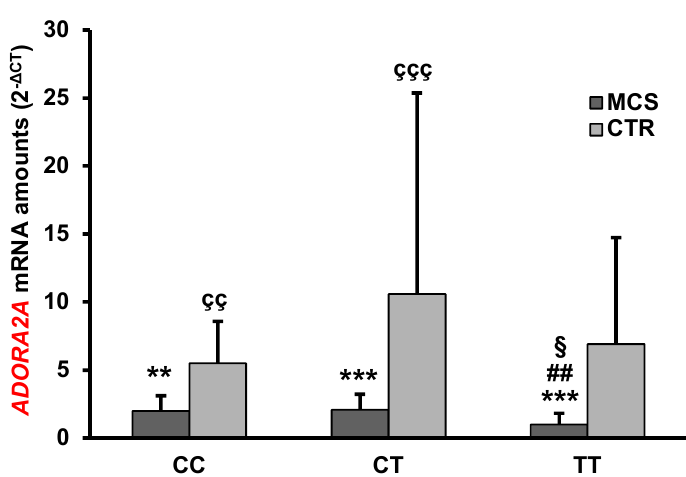
Figure 1. Mean ADORA2A mRNA expression levels in PBMC of MCS patients and healthy subjects (CTR) having different ADORA2A rs2298383 genotypes. Values shown are means ± SD. ** p < 0.01, *** p < 0.001 significant difference in comparison with CTR having the same genotype; ## p < 0.01 significant difference in comparison with CT MCS; § p < 0.05, significant difference in comparison with CC MCS; çç p < 0.01, ççç p < 0.001 significant difference in comparison with TT MCS.